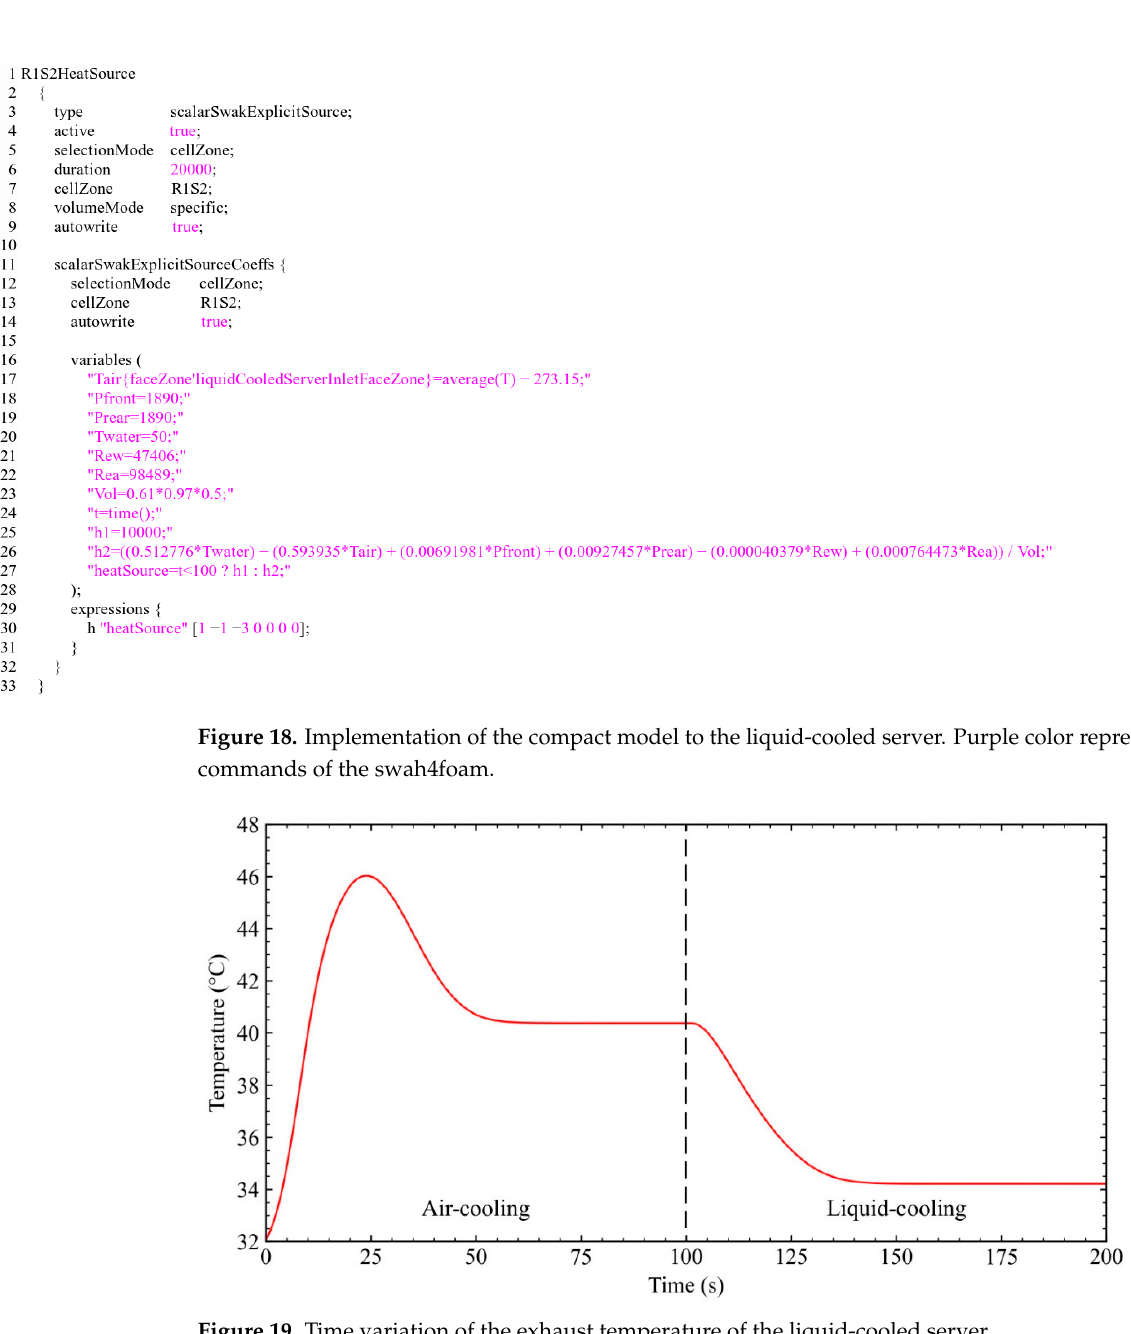
Figure 20. Distribution of the exhaust temperature of the rack. 4. Conclusions Air- and liquid-cooled servers can be deployed in a hybrid-cooled data center for the enhancement of cooling e ffi ciency and waste heat recovery. The energy transfer from the CPU to the air can be applied to the server as a heat source in the open-box modeling of air-cooled servers. However, the thermal simulation of liquid-cooled servers, considering heat transfer between the air, water and water pipes, as well as the e ff ect of the thermal paste between the CPU and cold plate, is challenging in the thermal management of a hybrid-cooled data center. To address this challenge, a CHT thermal model is developed and validated with experimental measurements from the literature considering the ther- mal paste. OpenFOAM fi les of the open source CHT model are publicly shared to increase dissemination of this study. The validated CHT model is used for the thermal analysis of an in-house developed cold plate design with a serpentine micro-channel for the e ff ective cooling and waste heat